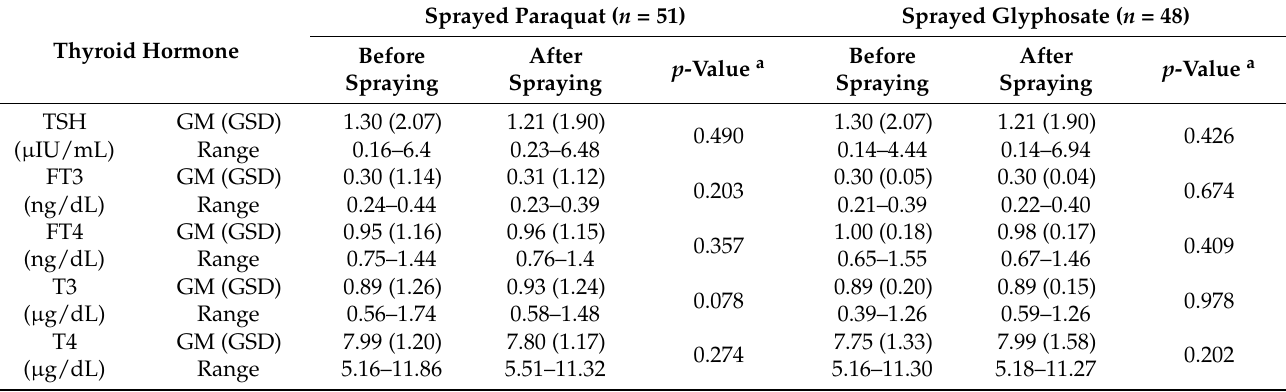
Table 6. Comparison between thyroid hormones on the day before and the day after spraying herbicides paraquat and